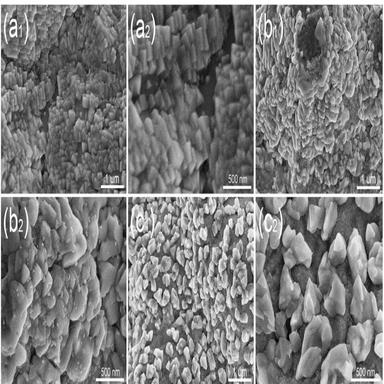
SEM images of (a) SnO2, (b) SnO2 @PPy-1, and (c) SnO2 @PPy-2.